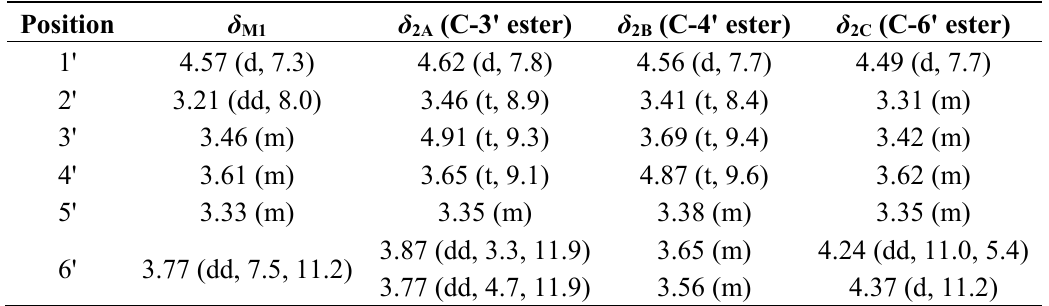
Table 3. 1 H-NMR data of the glycosyls in M1, 2A , 2B and 2C in CDCl J in Hz, recorded at 500 MHz).